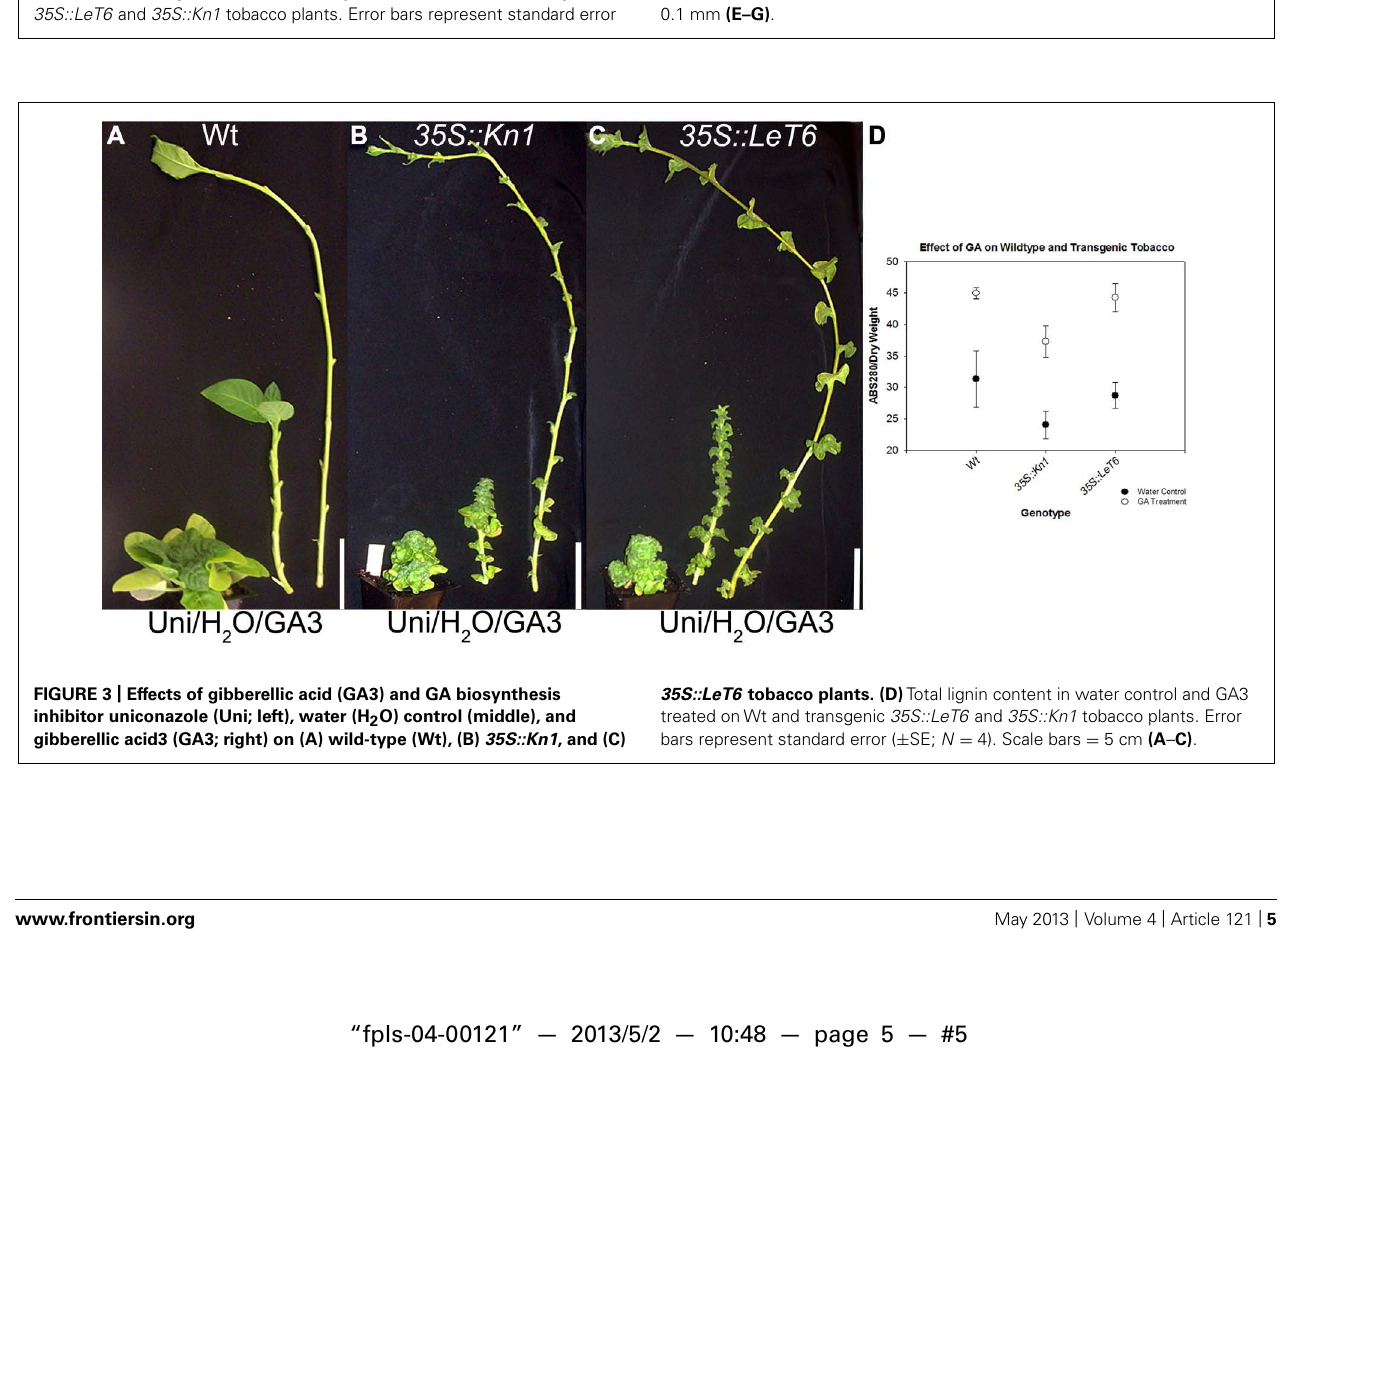
( ± SE; N = 4) where P < 0.001. Phloroglucinol stained cross sections of (E) Wt, (F) 35S::LeT6 , and (G) 35S:Kn1 tobacco stems. Scale bars = 5 cm (A–C) ; 0.1 mm (E–G) .